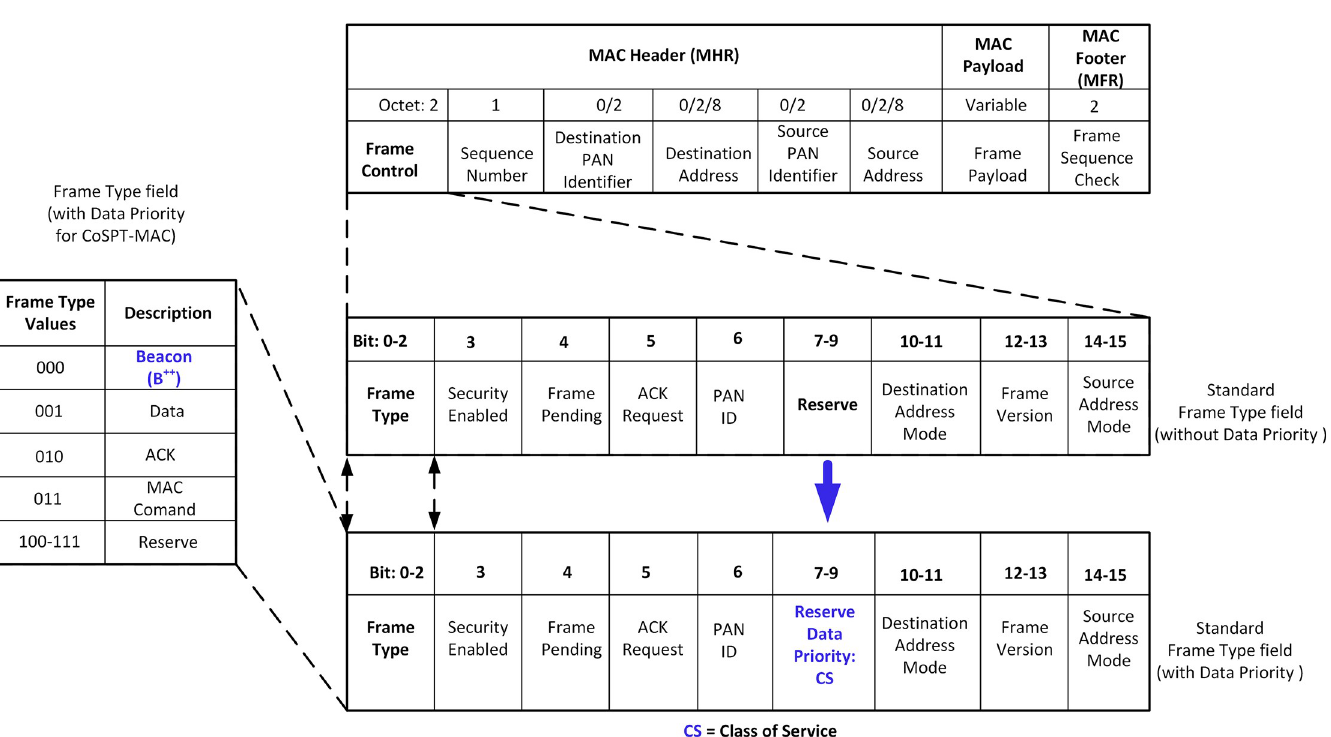
PLOS ONE | https://doi.org/10.1371/journal.pone.0237154 August 14,